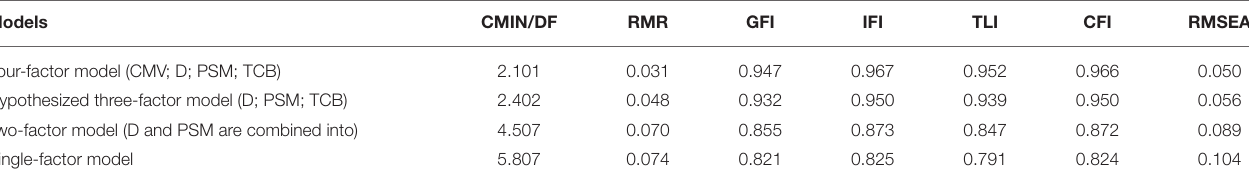
TABLE 5 | Results for confirmatory factor